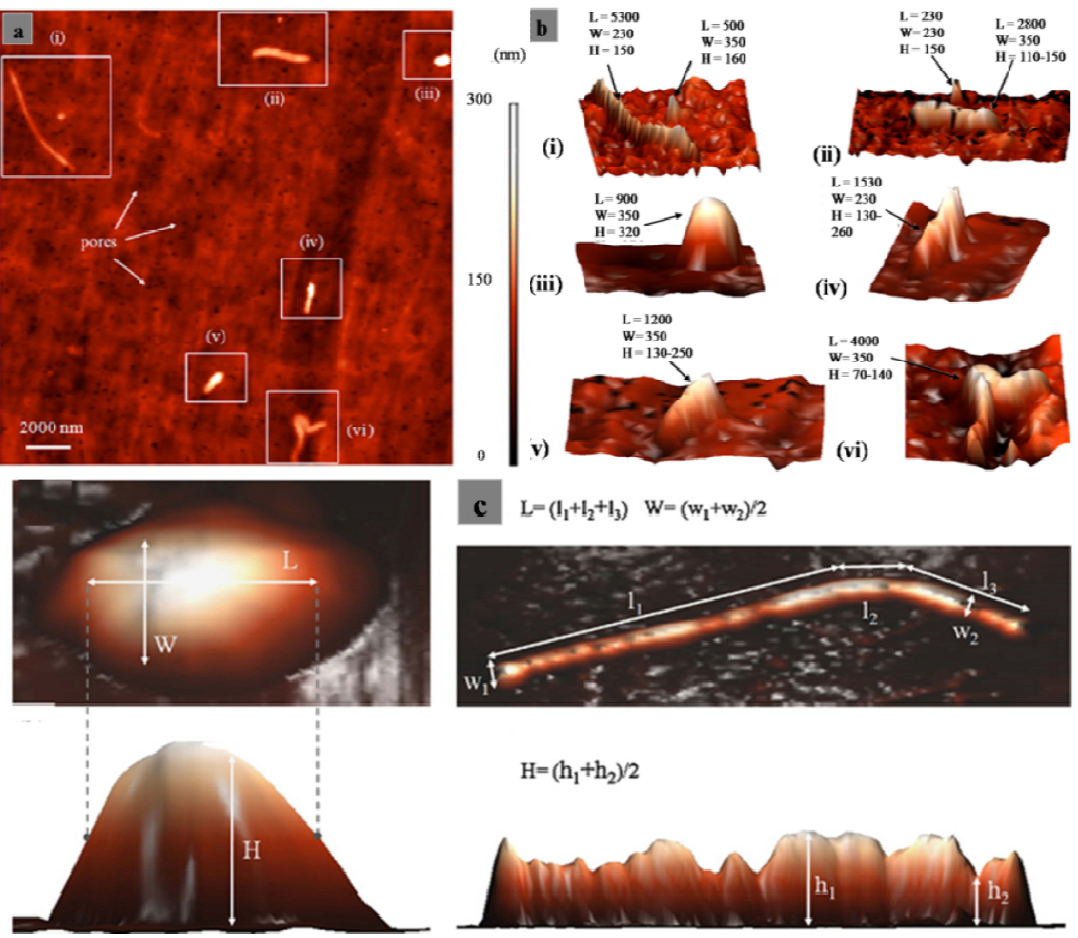
Figure 5. AFM morphology of UHMWPE wear debris [126]; ( a ) A two-dimensional projection of AFM data for debris particles of the 0.2–0.8 µm fraction precipitated on a filter. Six of the larger particles and three pores are indicated; ( b ) three-dimensional projections of AFM data for the six particles indicated in pane (dimensions are in nm); and ( c ) examples of length (L), width (W), and height (H) measurements on two representative UHMWPE